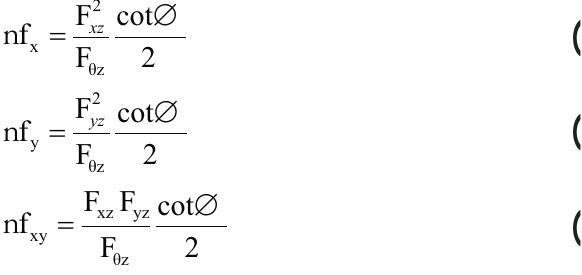
Minimum reinforcement ratios for f